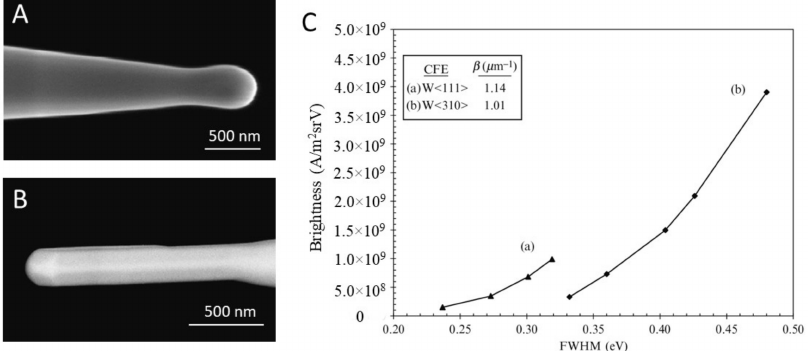
Figure 1. Scanning electron microscopy (SEM) photos of the W<310> ( A ) and W<111> ( B ) cold field emission (CFE) sources; ( C ) The source reduced brightness B r versus the corresponding Full width at half maximum (FWHM(E)) values for the two CFE sources. Reproduced with permission from [4], Copyright Elsevier,